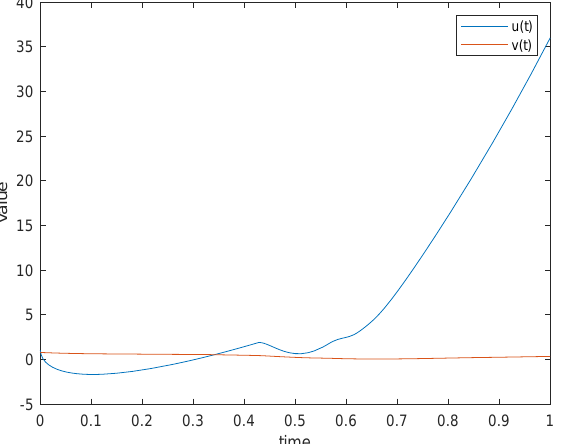
Figure 3. Numerical simulation of solutions of Example 2.